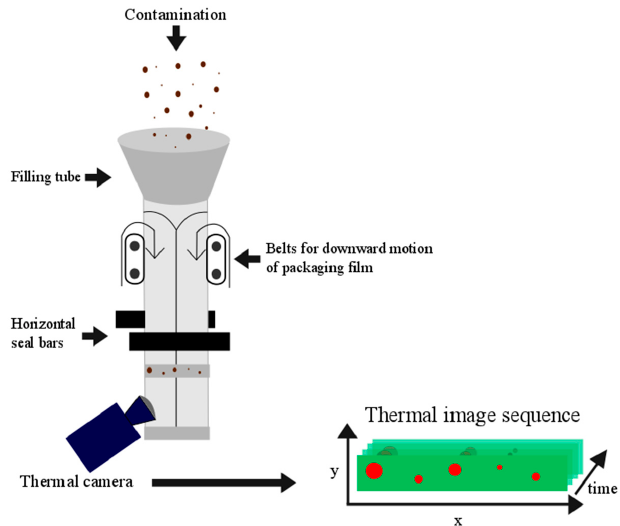
Figure 1. Schematic representation of the vertical form fill seal (VFFS) setup used for contaminated seal sample preparation and thermal image recording.